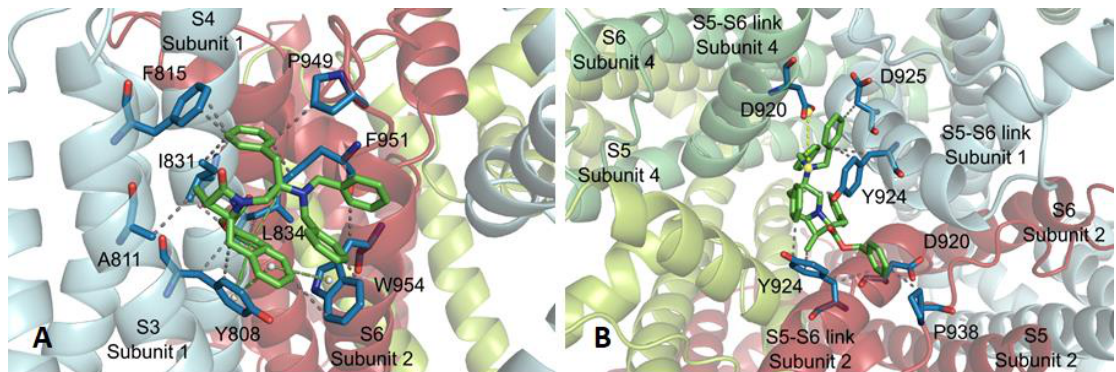
Figure A4 . Subsite 3 ( A ) for β -lactam 14 and subsite 4 for β -lactam 16 ( B ). WdV interactions are indicated by dotted gray lines, and π–π stacking by centroids and non-continuous pale green lines. Channel residues involved in the interactions are shown in blue and labelled.